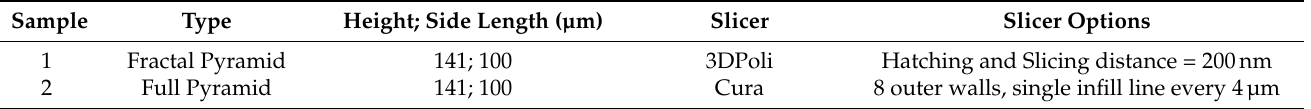
Table 1. Summary of the two sample geometries.